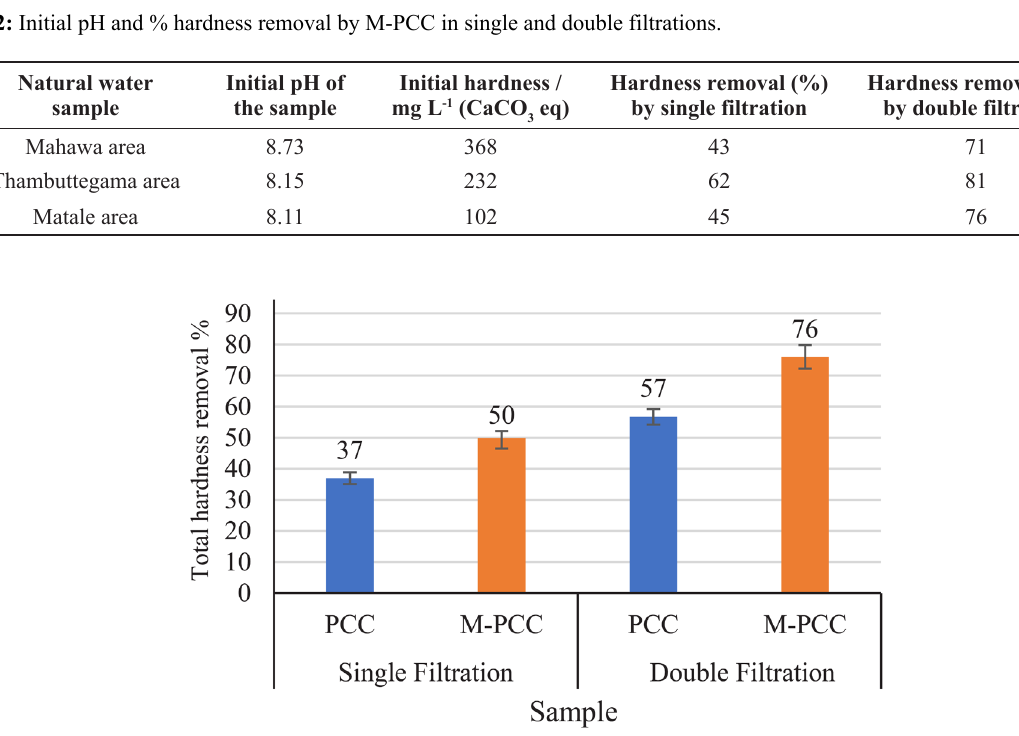
Figure 3: Comparison of total hardness removal by PCC and M-PCC in single and double